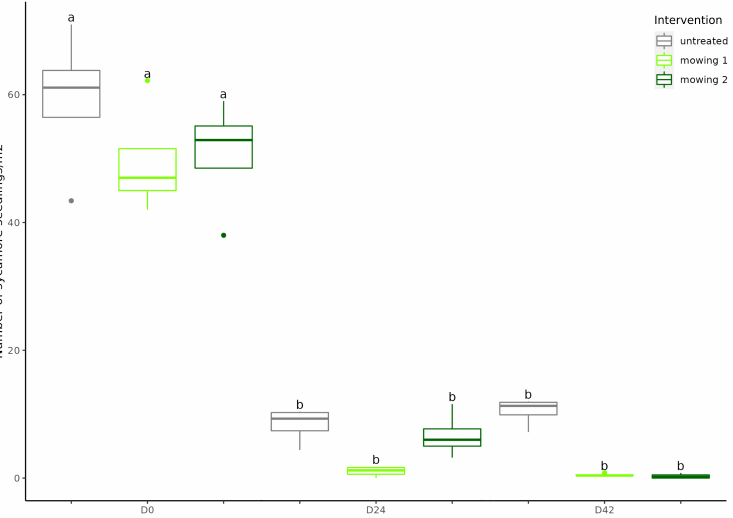
Figure 4. Results of experiment 2: mean number of sycamore seedlings before any intervention (D0, i.e., 5 April 2019) and 24 (D24, i.e., 29 April 2019) or 42 (D42, i.e., the 20 June 2019) days later. Untreated condition, mowing 1 (done on 5 April 2019) and mowing 2 (done on 29 April 2019) are represented in grey, light and dark green, respectively. Letters indicate significantly different results of the two-way ANOVA with a post-hoc Tukey test with p < 0.05. Outliers are represented with a